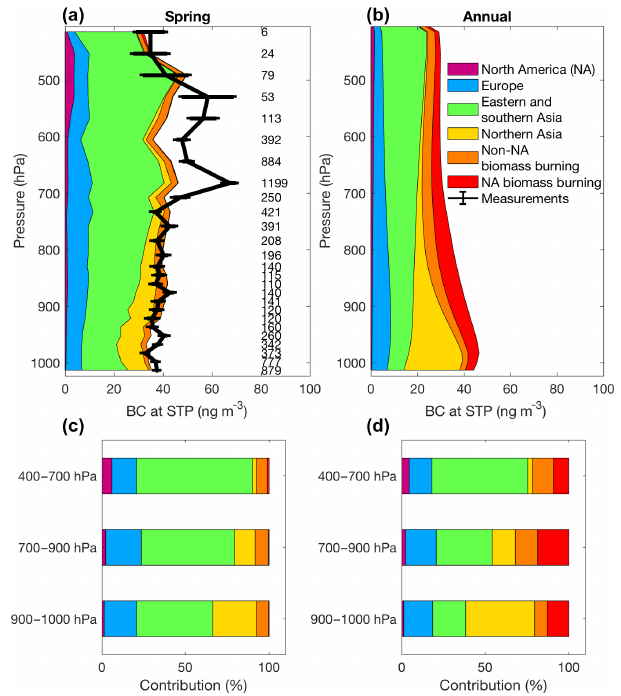
Figure 11. GEOS-Chem adjoint modelling results for BC sources to the Arctic. Panels (a) and (b) show in colour the contributions of BC from different anthropogenic emission and biomass burning regions to the vertical profiles in the atmosphere, where the measurements are in black. Modelled results are for the entire Arctic for the annual average. The data are binned in pressure ranges in panels (c) and (d) . Numbers of measurements are along the y axis. Figure from Xu et al. (2017).